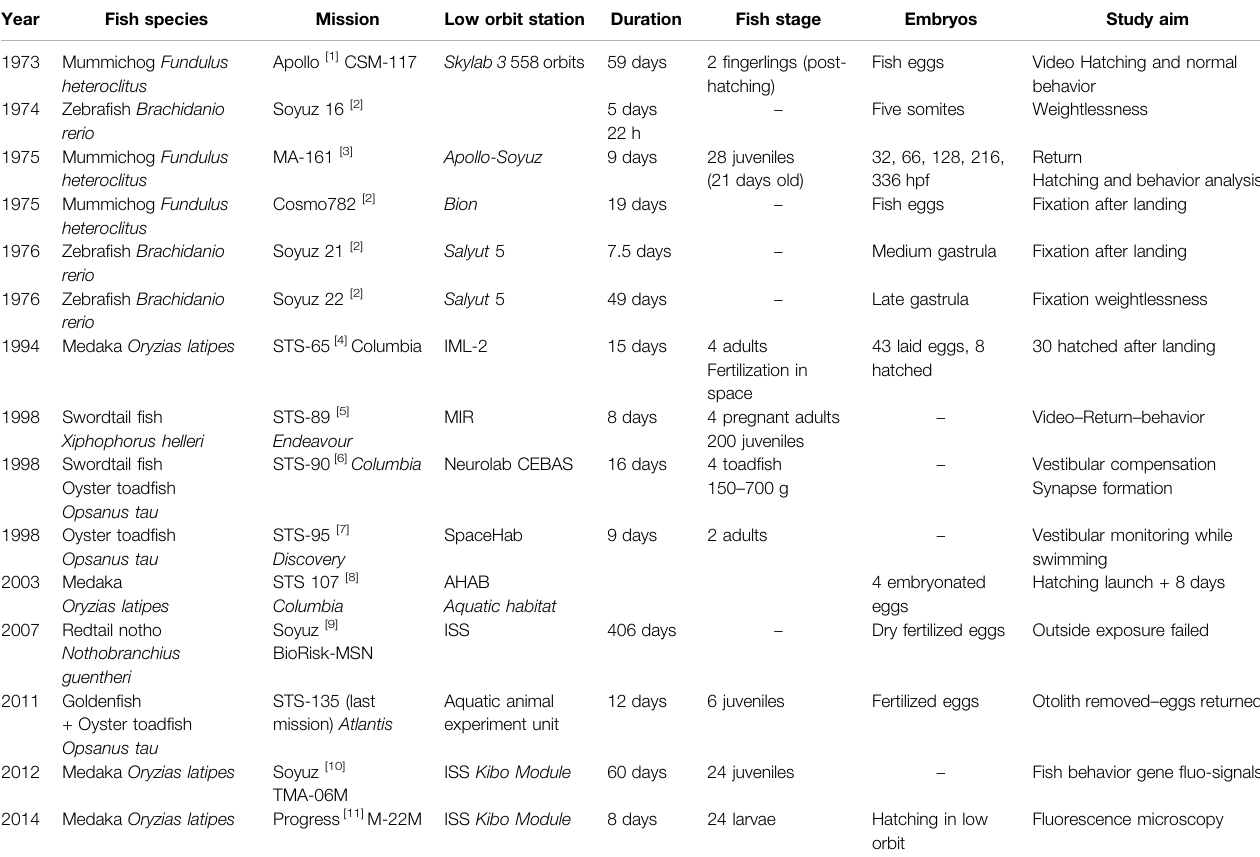
TABLE2| Studiesofornamental fi shusedasaphysiologicalmodelinloworbitmissions.Referencestomajormissionsarenotedwithnumbersinbrackets:[1]Baumgarten, 1975; [2] Proshchina, 2021; [3] Hoffman, 1977; [4] Ijiri, 1998; [5] Anken, 2000; [6] Anken, 2002; [7] Boyle, 2001; [8] Niihori, 2004; [9] Baranov et al., 2009; [10] Chatani, 2015; Murata, 2015; [11] Chatani,